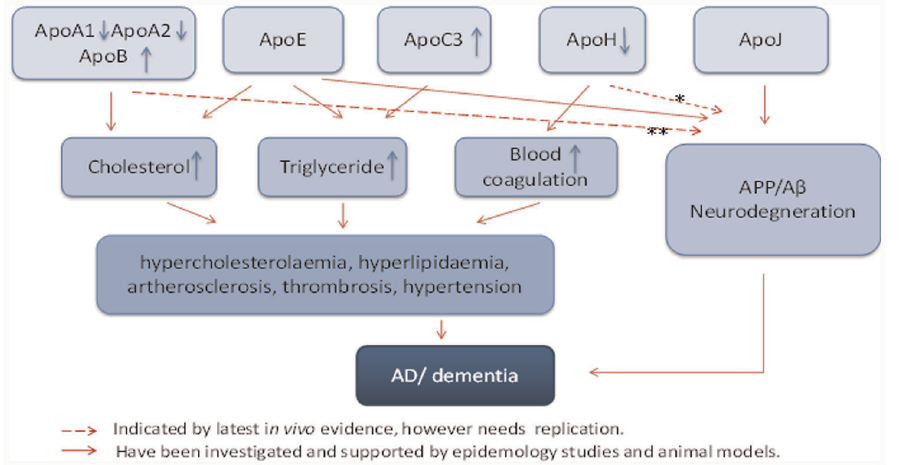
Figure 1. Potential pathophysiological mechanisms involving apolipoproteins in Alzheimer’s disease. Literature evidence: *, Katzav, Faust-Socher et al. 2011; George and Erkan 2009. **, Lewis, Cao et al. 2010; Roher, Maarouf et al. 2009; Martins, Berger et al. 2009; Bereczki, Bernat et al. 2008.